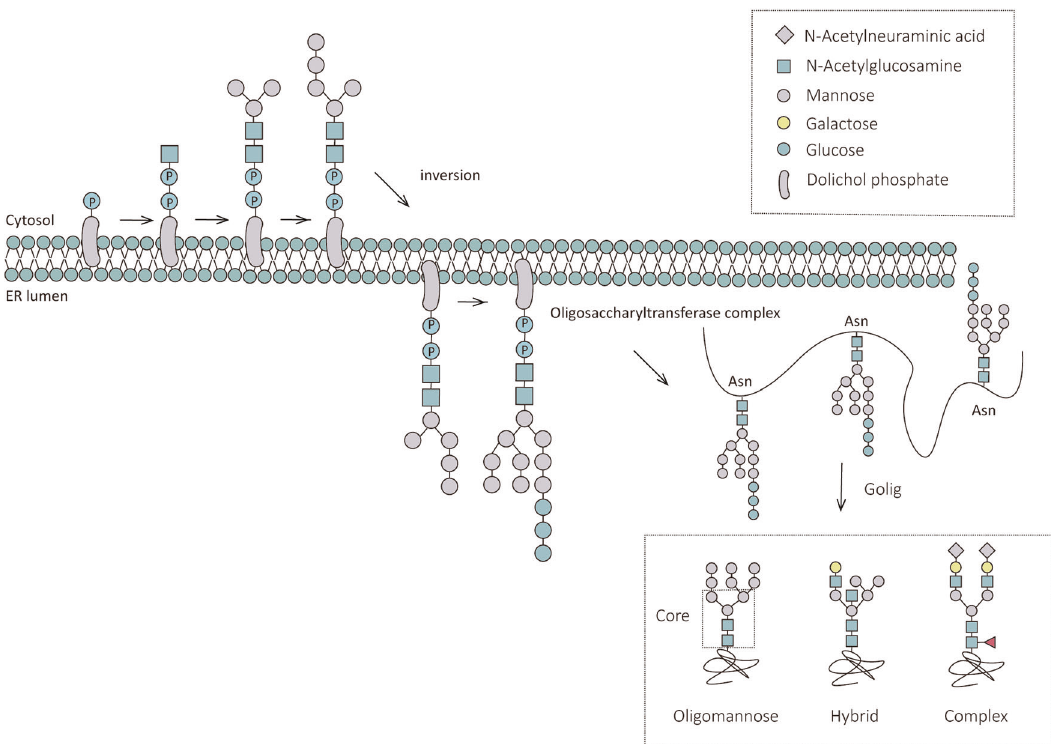
Fig. 1 The process of N-glycosylation. N-glycosylation modi fi cations begin at the endoplasmic reticulum and end at the Golgi apparatus. The new oligosaccharide chains are initially processed in the endoplasmic reticulum and then transferred to the N-glycosylation sites of the new peptide chains by the action of the oligosaccharyltransferase complex (OST), and the attached polypeptide chains will undergo further processing and modi fi cation in the Golgi apparatus to form three N-glycan types, oligomannose, hybrid, and